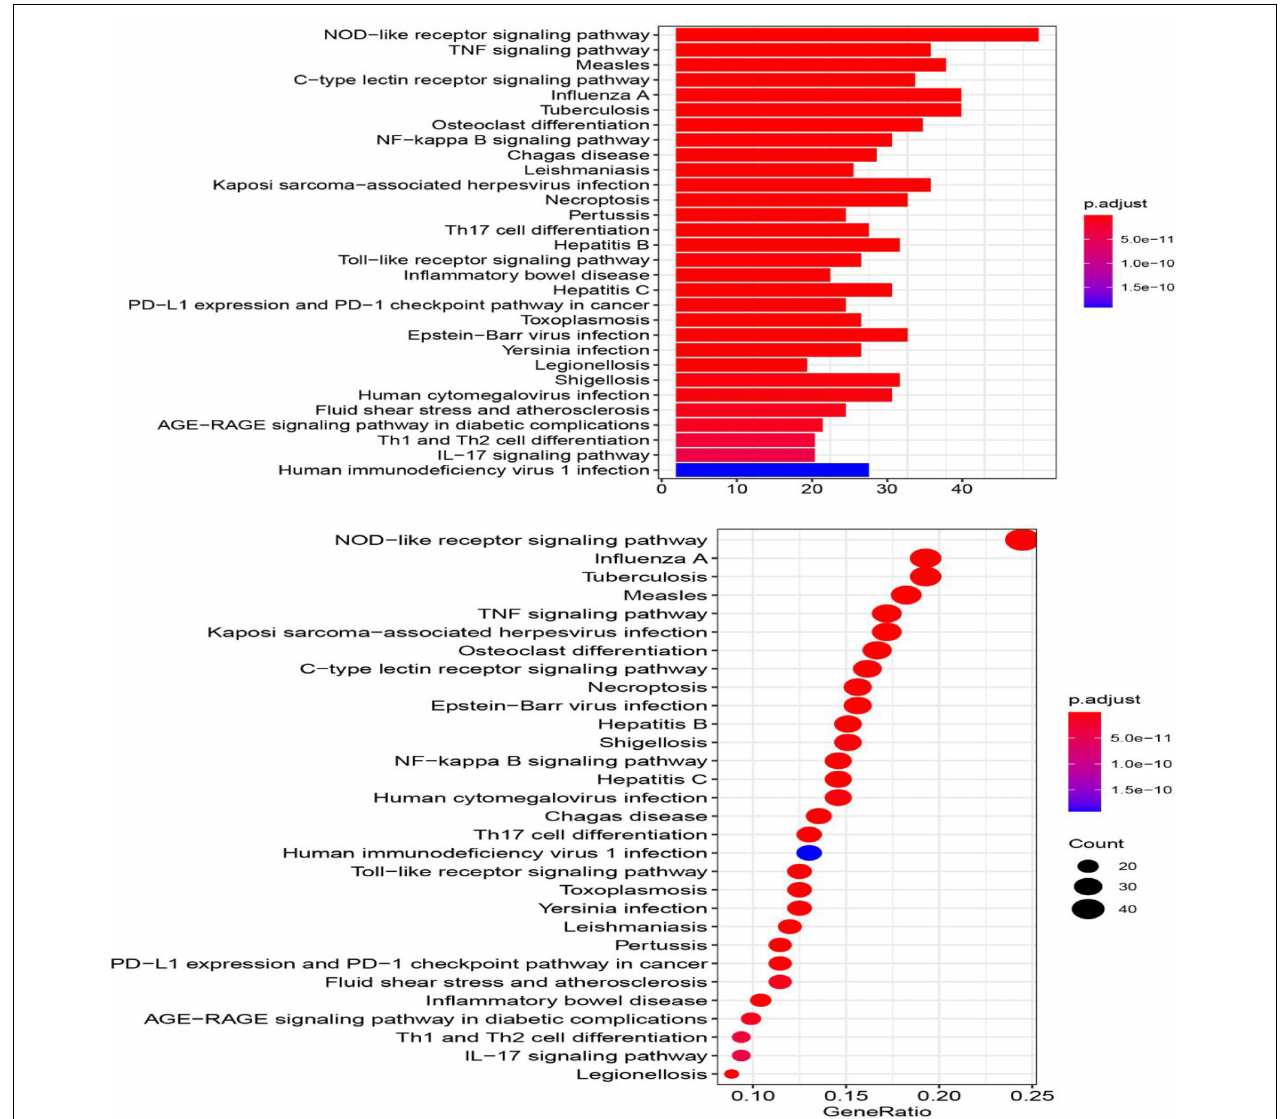
FIGURE 9 | The top 30 KEGG pathways enriched in the immune-related crosstalk genes.